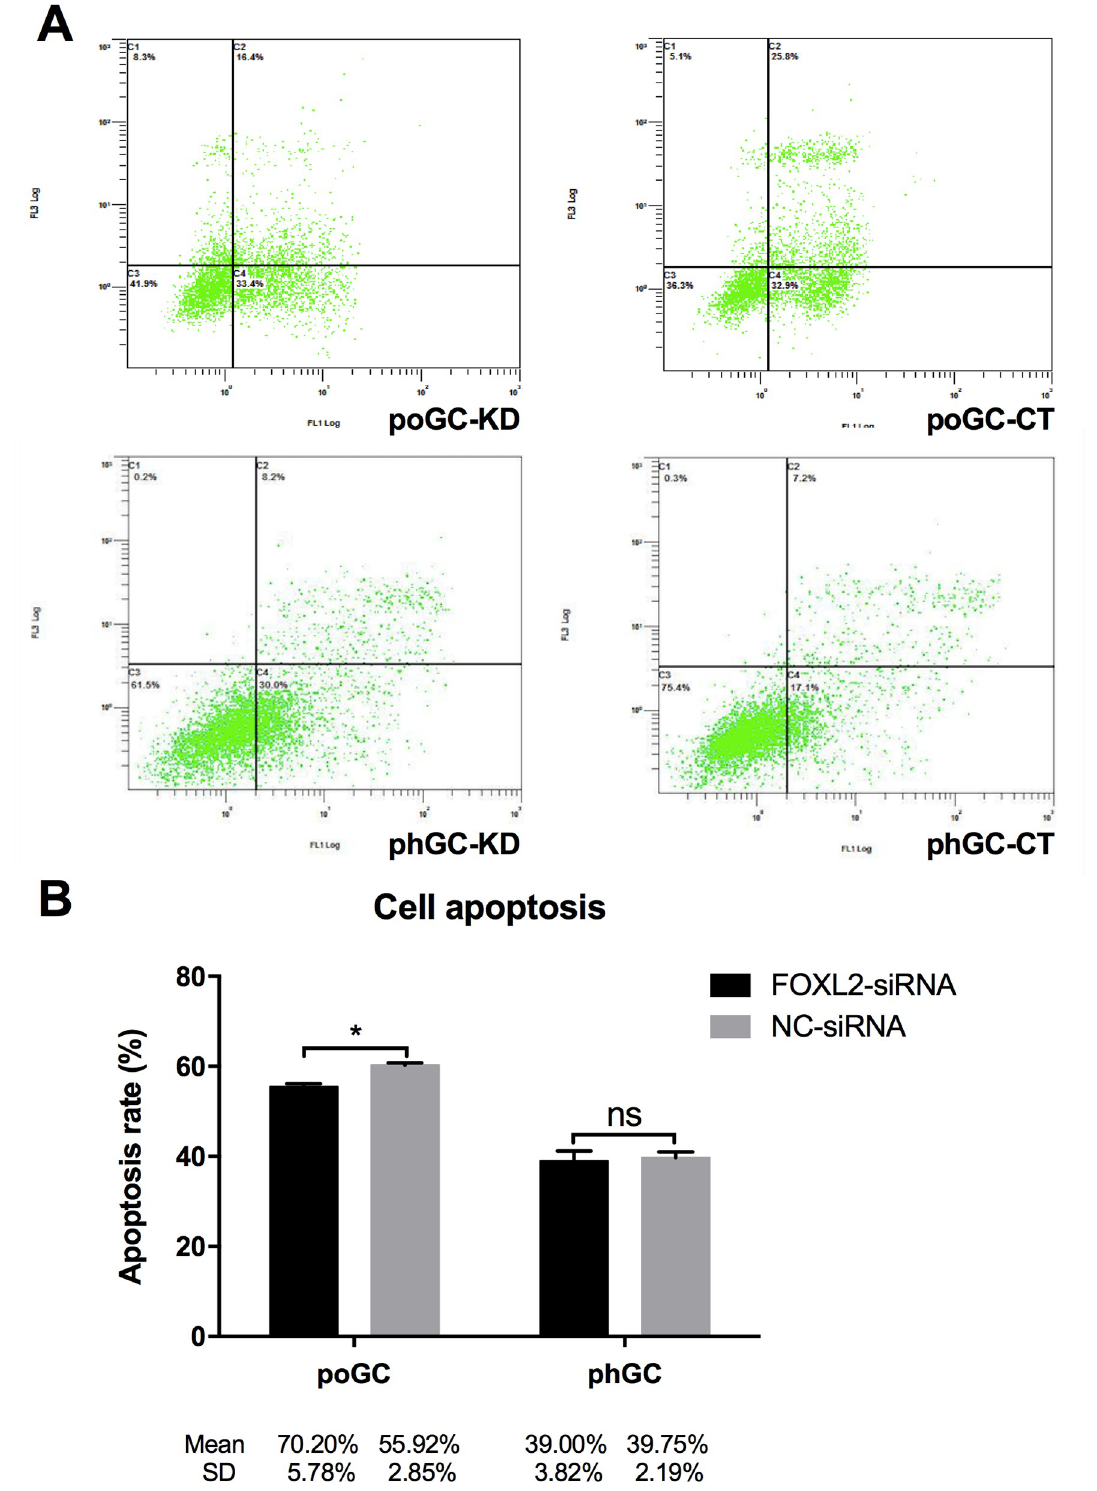
Fig 8. The effect of knocking down FOXL2 on chicken granulosa cell apoptosis. poGC and phGC were transfected with FOXL2-siRNA or NC-siRNA, and the number of cells undergoing apoptosis was determined using a flow cytometer 48 h post- transfection. (A) Cell apoptosis of the groups (poGC-KD, poGC-CT, phGC-KD and phGC-CT) was determined by flow cytometry.